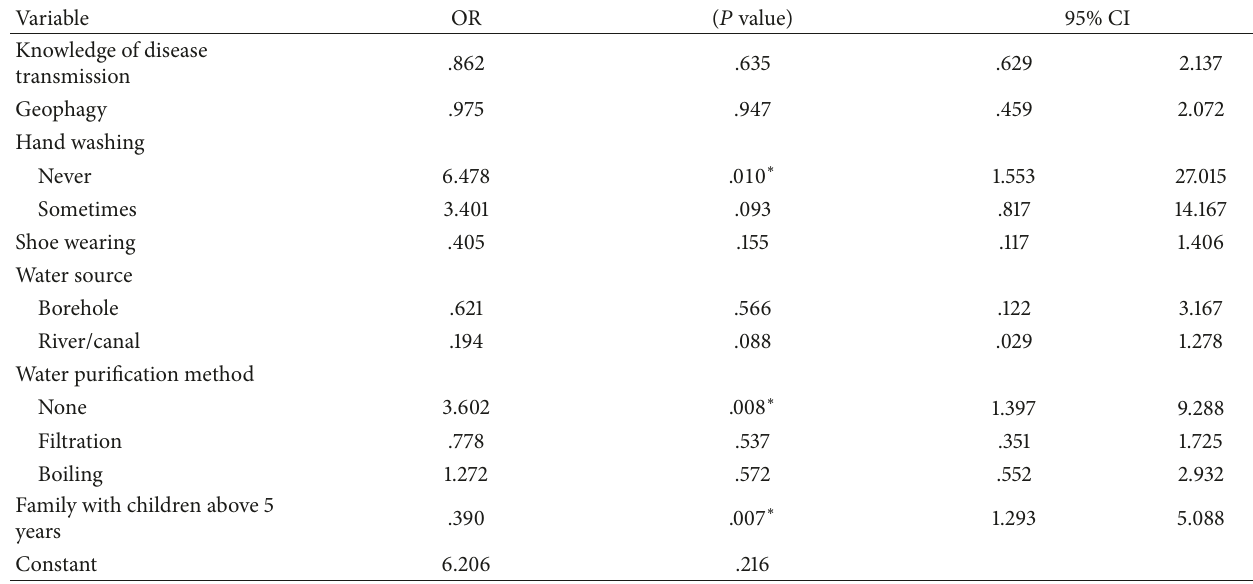
Table 7: Factors associated with the general prevalence of infection in preschool age children in Mwea division: a binary logistic regression